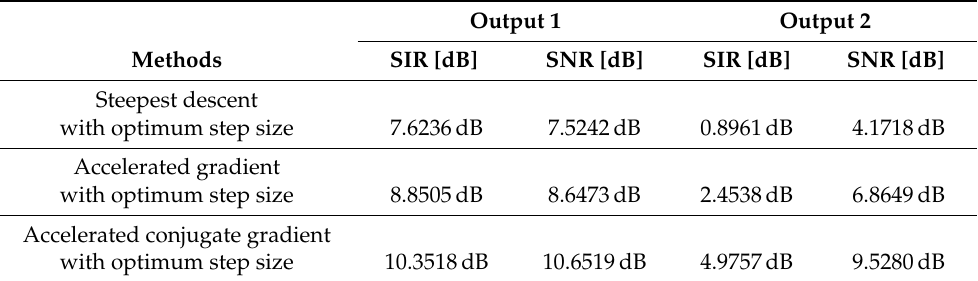
Table 3. Second order BSS in a real car recording environment with two speech sources, noise, and three microphones for the dominant speech output detected by the kurtosis. The SNR is 0dB.